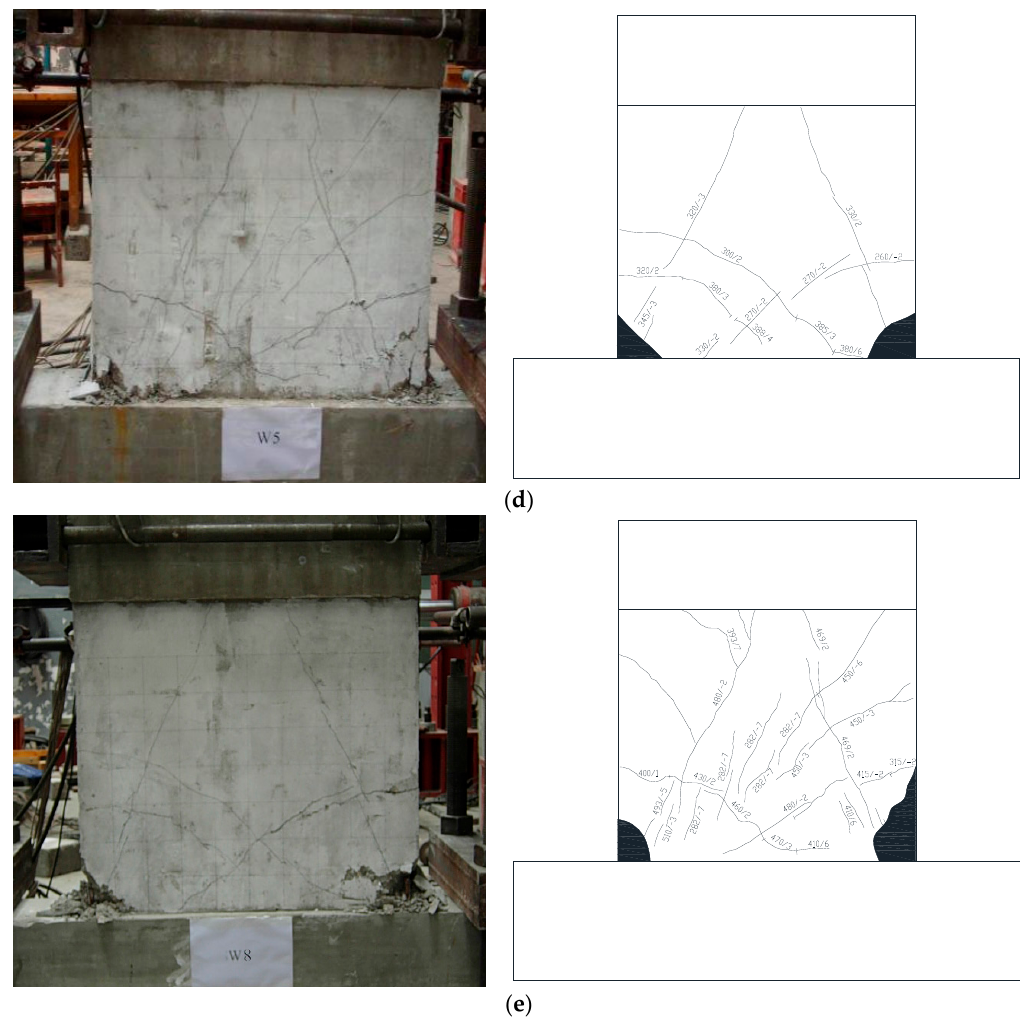
Figure 7. Failure characteristics. ( a ) Specimen W1; ( b ) Concrete crush of specimen W1; ( c ) Concrete crush of specimen W4; ( d ) Specimen W5; ( e ) Specimen W8.